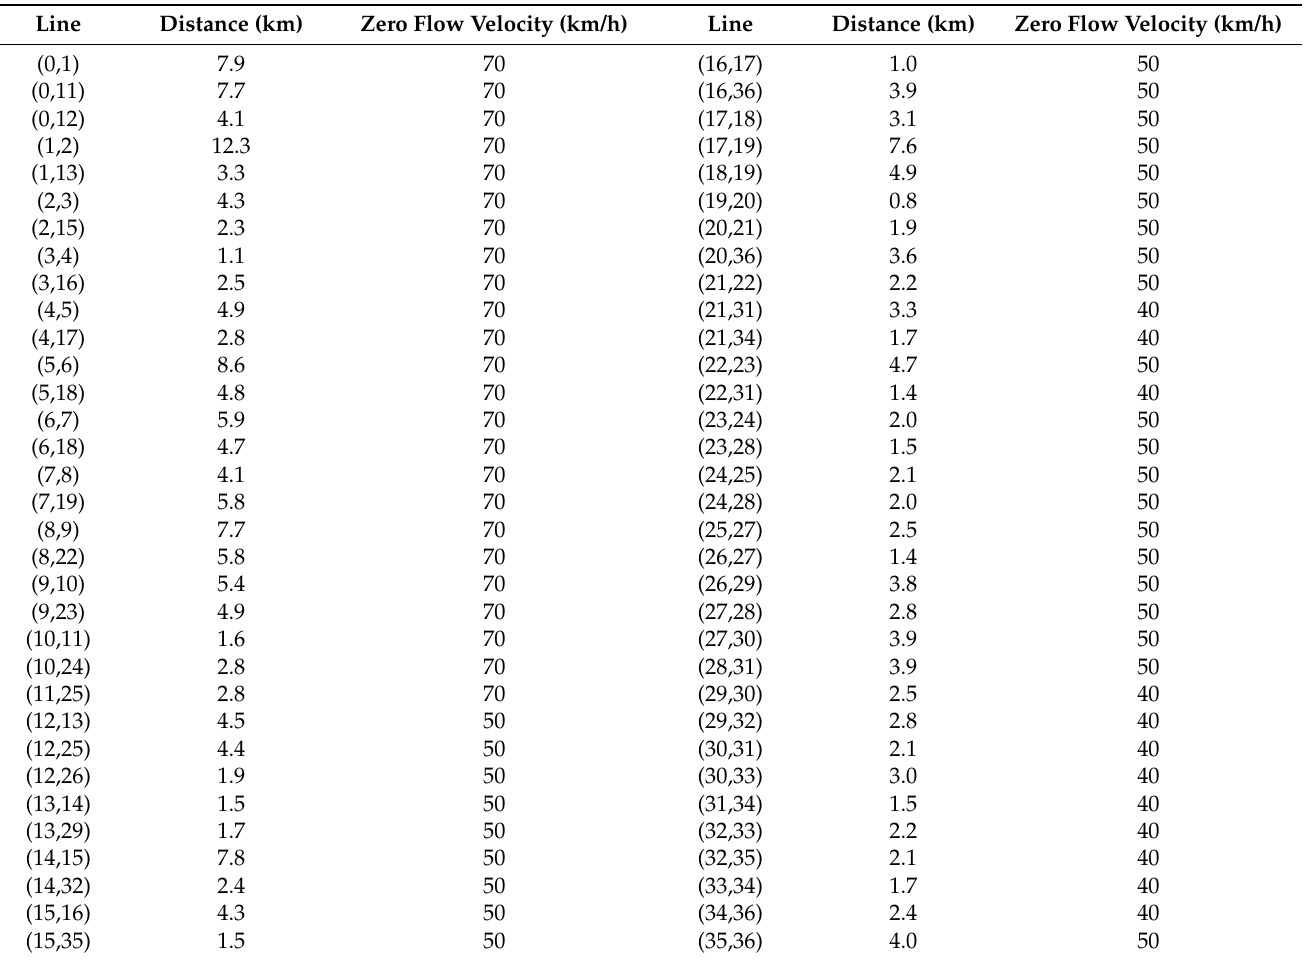
Table 6. Parameters of traffic roads (0–36